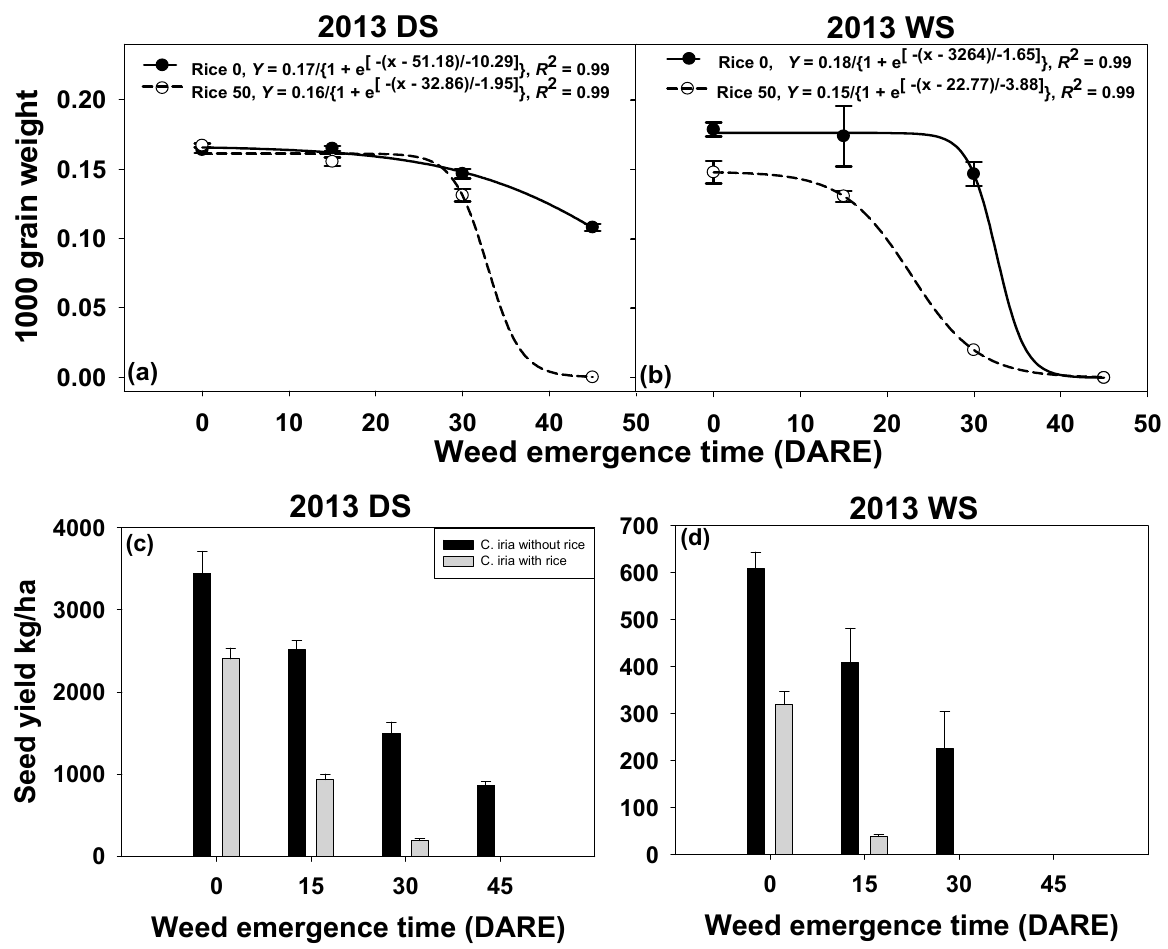
Figure 6. Influence of weed emergence time on C. iria 1000-seed weight in g plant − 1 ( a , b ) and seed yield kg ha − 1 ( c , d ). Black bar graphs and solid lines symbolize the data for C. iria grown alone without rice (Rice 0), and grey bar graphs and broken lines symbolize that for C. iria grown with rice at a seed rate of 50 kg ha − 1 (Rice 50). The standard error of the means is represented by vertical bars.